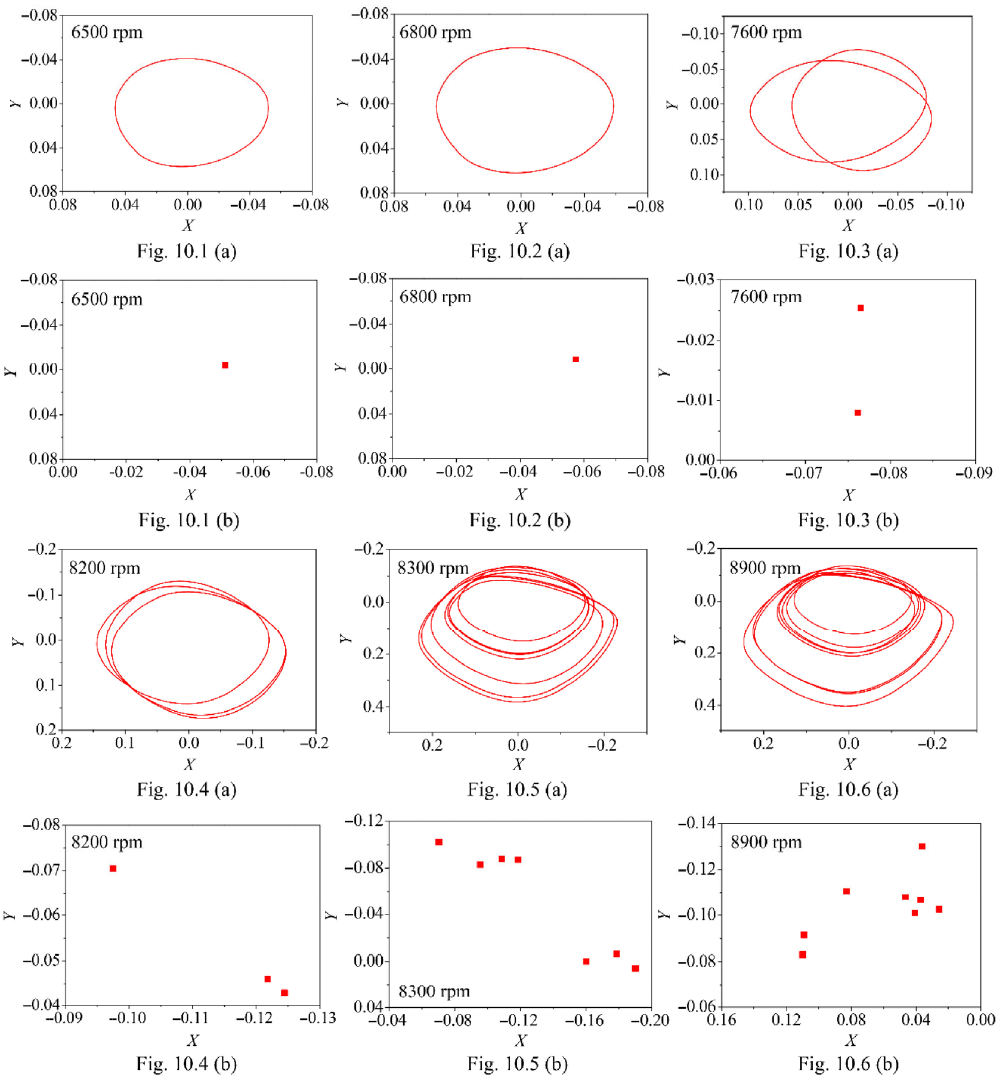
Fig. 10 (a) Journal center orbits; (b) Poincaré maps at 6,500 rpm, 6,800 rpm, 7,600 rpm, 8,200 rpm, 8,300 rpm, and 8,900 rpm with turbulent and thermal